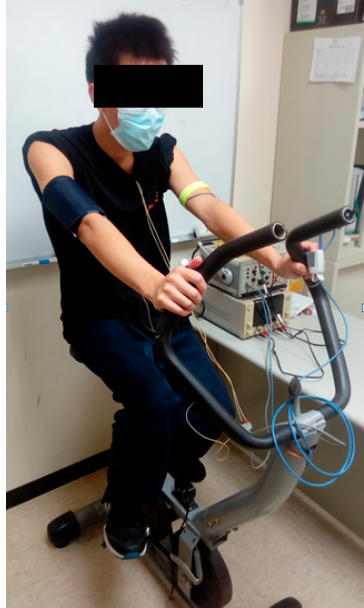
Figure 8. The real photo of the experiment.